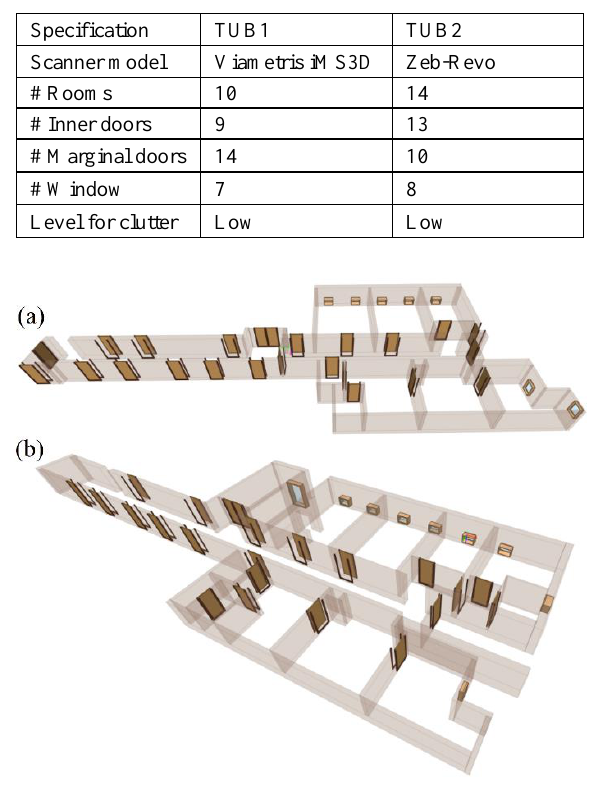
Figure 7. Interior models of the scanned building created by the data provider. (a) . TUB1. (b)